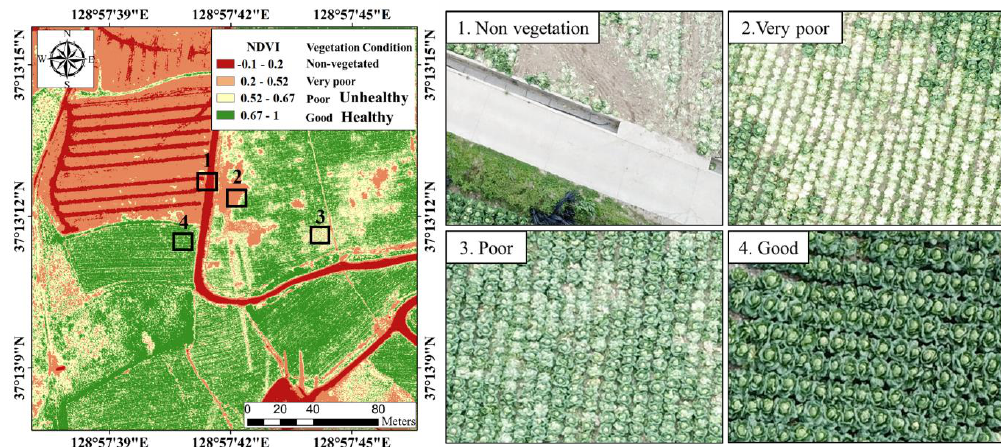
Figure 19. p-NDVI map according to the vegetation distribution (left) and cabbage status in each category (right).